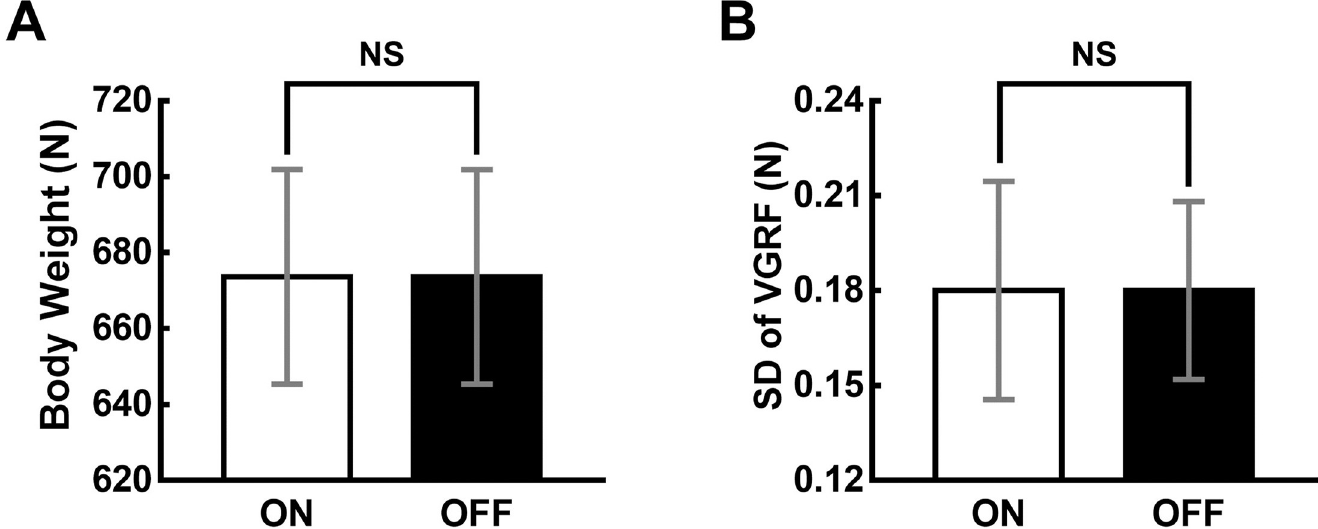
Fig 5. The body weight (BW) and standard deviation (SD) of the vertical ground reaction force (VGRF) during the BW calculation phase. (A) The BWs of 20 participants under the two experimental conditions (ON: Vibration at 130% of the sensory threshold, OFF: No vibration). (B) The SD of the VGRF during the BW calculation phase of 20 participants under the two experimental conditions. The error bars and NS denote standard errors and no statistically significant difference (p > 0.05), respectively.